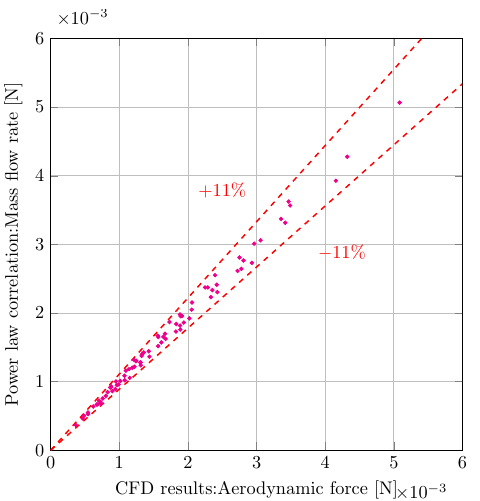
Figure 21. Viscous force empirical model: CFD simulations versus empirical